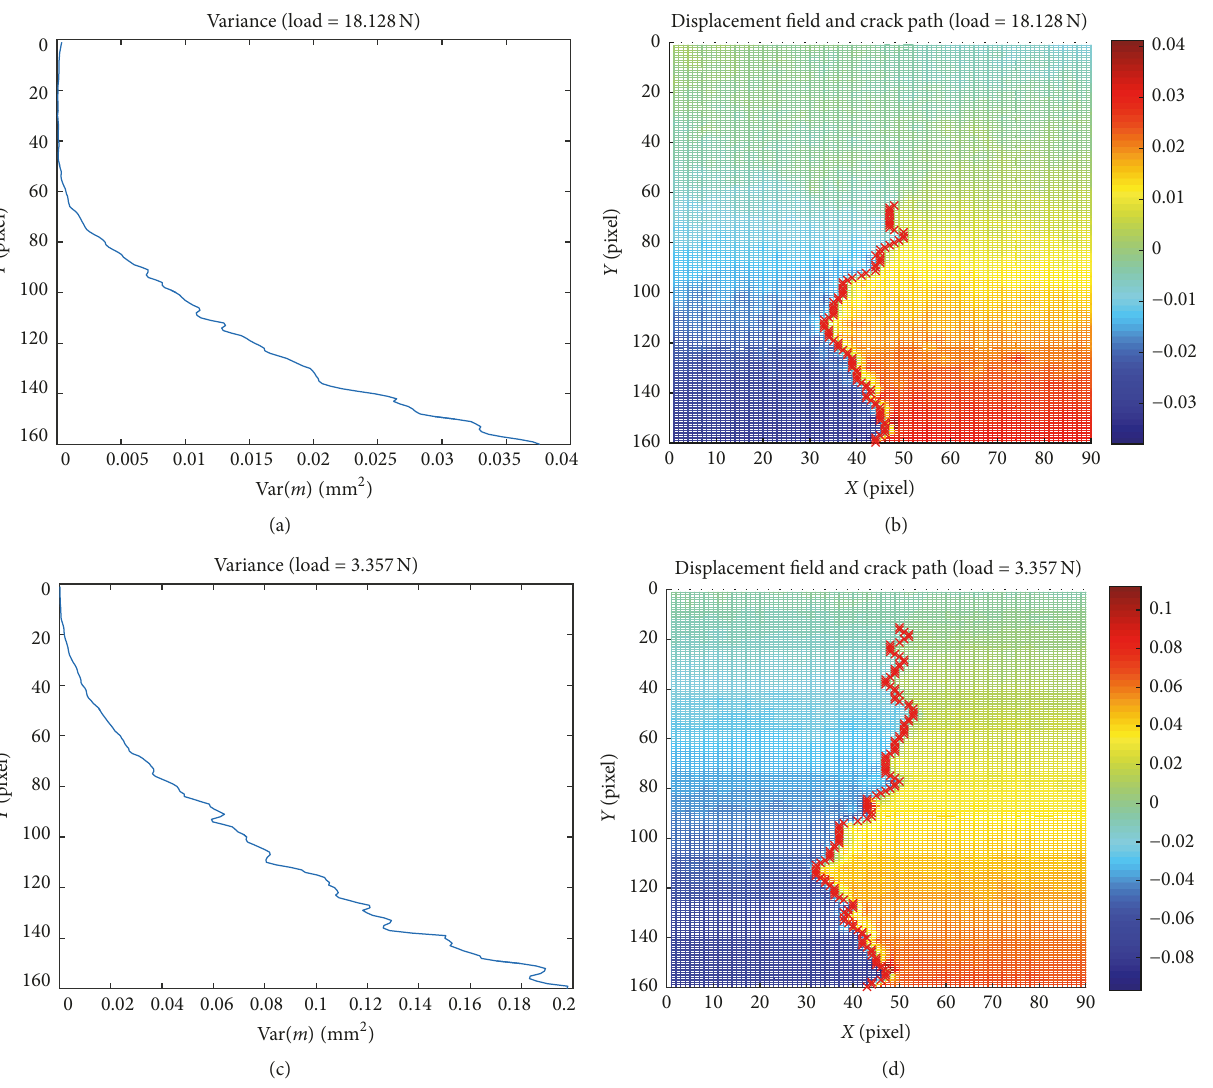
Figure 6: Distributions of 𝑉 and delineated cracks on the displacement maps under different loads.